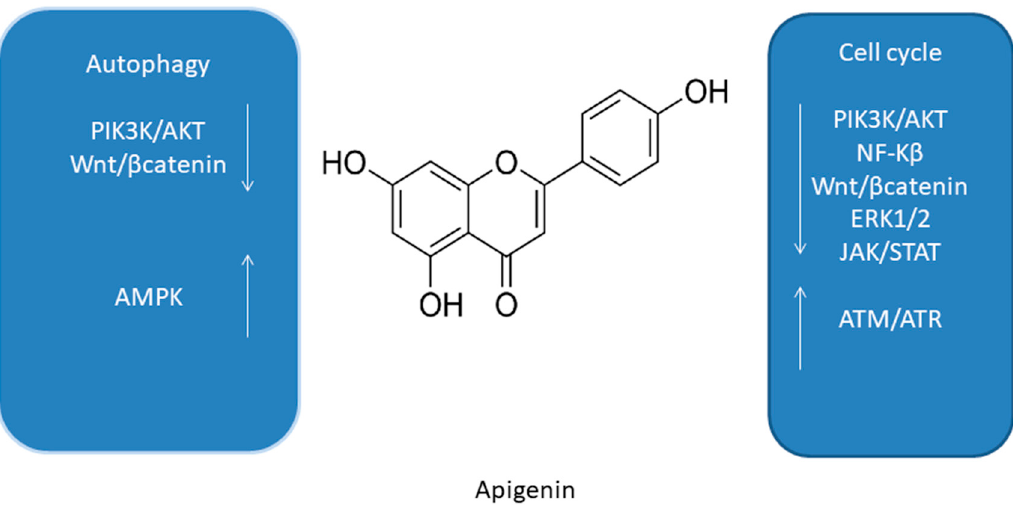
Figure 4. Summary of molecular cell cycle and autophagy signaling pathways of apigenin [66,71,78–80].